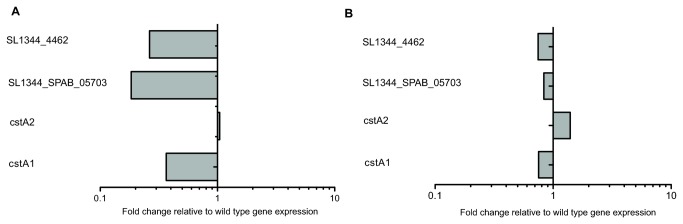
qRT-PCR analyses of differentially expressed genes of the S.
Typhimurium ΔyehUT mutant. A The relative expression levels of the 4 genes found to be differentially expressed on microarray analysis of the S. Typhimurium ΔyehUT mutant when compared to S. Typhimurium. in low salt LB, at mid-log phase, at 37°C (Table S6 in File S1). The 4 genes examined are listed on the y-axis. Grey boxes < 1.0 indicates down regulated genes and grey boxes >1.0 indicates up regulated genes relative to S. Typhimurium. B qRT-PCR analysis showing relative expression levels of genes after complementation of the ΔyehUT mutant compared to S. Typhimurium.(Table S6 in File S1).